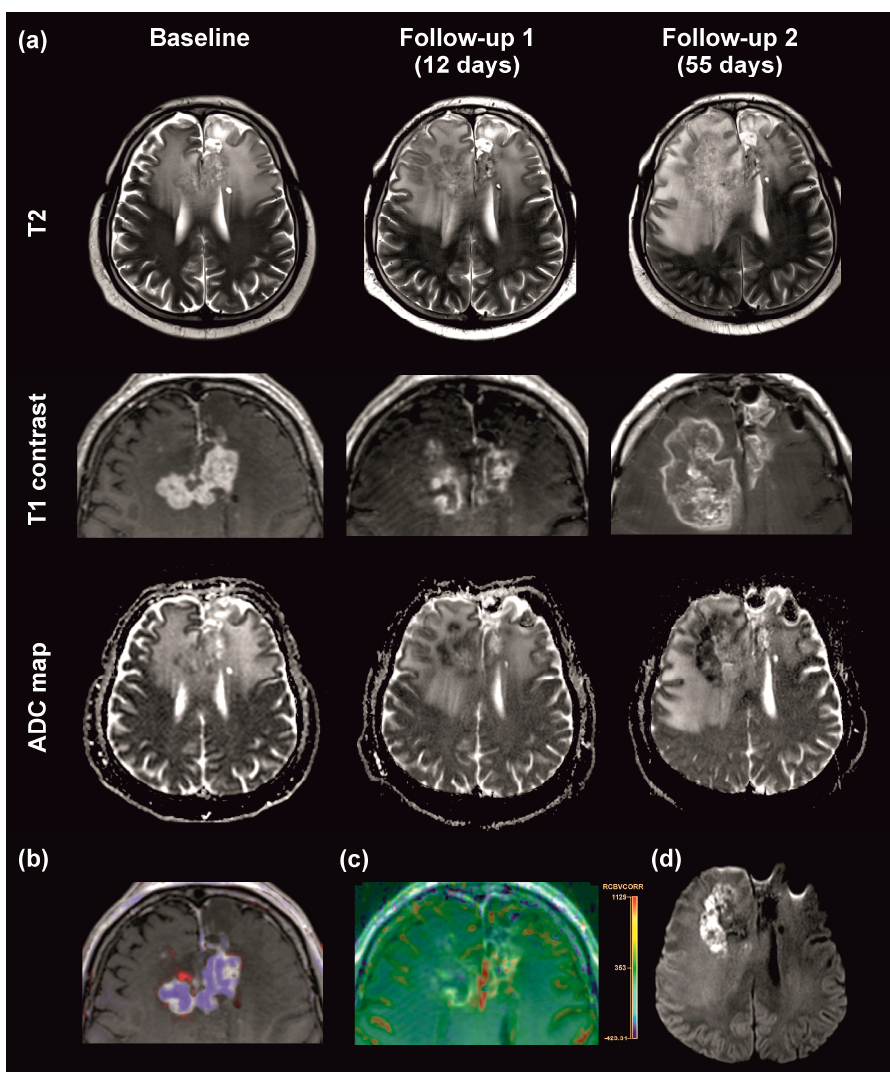
Figure 2. Magnetic resonance imaging (MRI) alterations in a regorafenib-induced T2-dominant progression pattern. ( a ) MRI scans were performed at baseline and the indicated intervals after initiation of REG therapy. T2 weighted images (T2, upper row), contrast enhanced T1 weighted images (T1 contrast, middle row), and apparent diffusion coefficients (ADC) maps (lower row) are depicted. “T2-dominant” progression is characterized by an overall decrease of contrast-enhancement and simultaneous increase in T2 hypointense tumor areas in the right frontal lobe. ( b ) Comparison of T1 contrast images at baseline and after 12 days. Areas of decreasing signal intensity are segmented in blue, areas of increasing intensity are segmented in red. ( c ) Color-coded perfusion map for leakage corrected cerebral blood volume (CBV) showing patchy, red areas with markedly increased CBV within the tumor outside of areas with reduced ADC. ( d ) Diffusion-weighted b 1000 image corresponding to corresponding ADC map at 55 days.